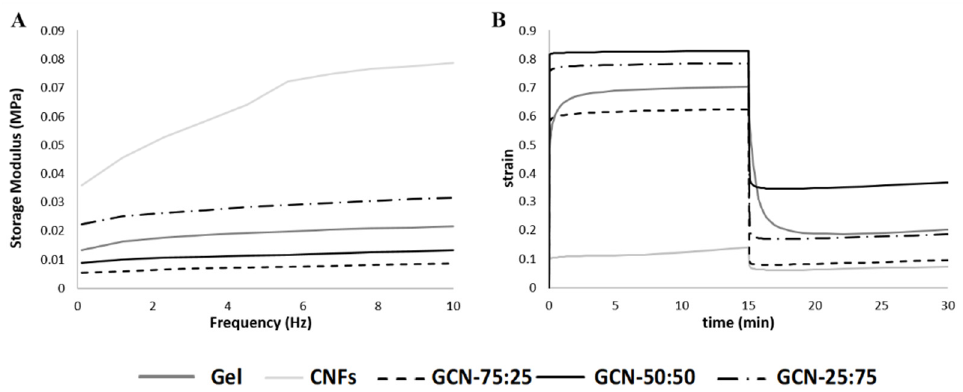
Figure 6. Compressive mechanical test of the Gel–CNF biocomposites previously immersed in PBS at 37 °C overnight. ( A ) The average storage modulus (E’)-frequency curves from 0.1 Hz to 10 Hz ( n = 5); and ( B ) the average creep curves obtained in a creep time of 15 min and a recovery time of 15 min ( n = 5).